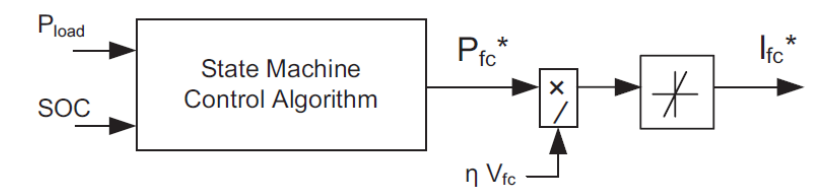
Figure 5. State machine control.